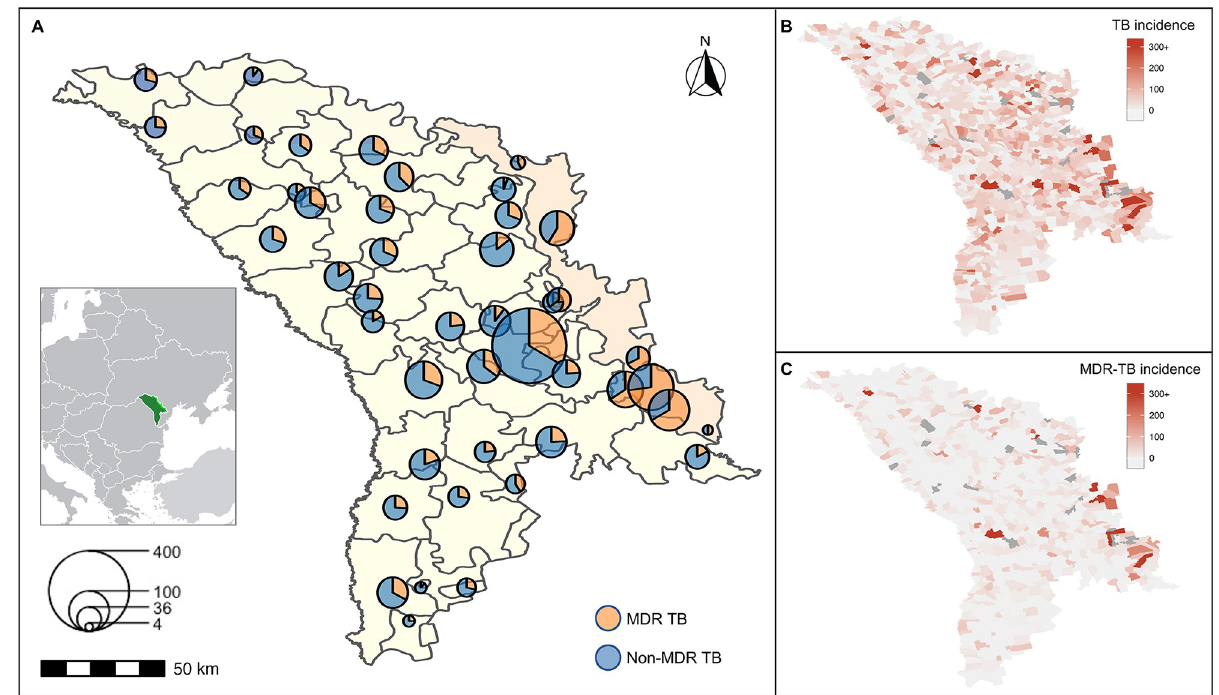
Fig 1. (A) Map of culture-confirmed TB patients in Moldova. The center of each circle represents the geometric center of the localities/region (709 named localities within 50 regions) where the case was diagnosed and sampled. The scale indicates the number of culture-confirmed TB patients ( n = 2,236). The Transnistrian region of Moldova is highlighted. The geographic distribution of the notified incidence of all culture-confirmed (B) TB and (C) MDR-TB by locality. The colors show the distribution of notified case per population and localities colored dark gray have missing population data. The map data were extracted from the GADM database (www.gadm.org/download_country.html). MDR-TB, multidrug-resistant tuberculosis; TB, tuberculosis.